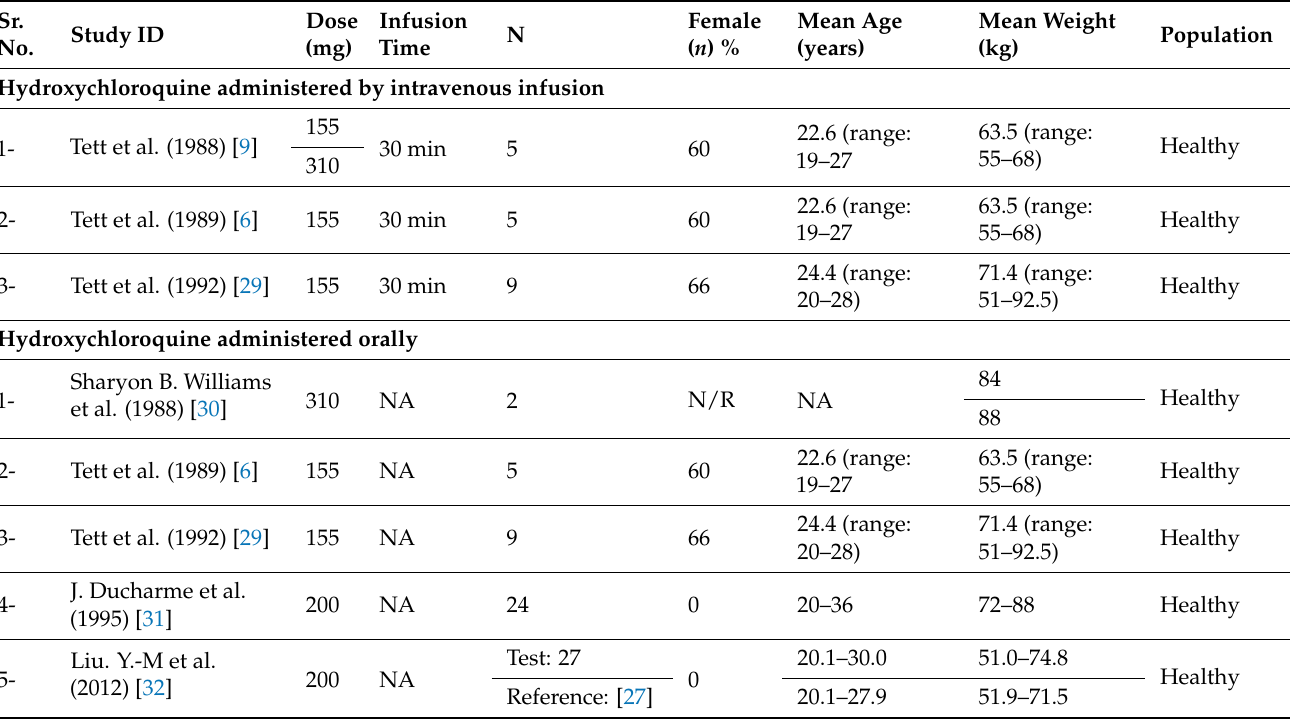
Table 1. List of clinical PK data of hydroxychloroquine obtained from published studies utilized in PBPK model